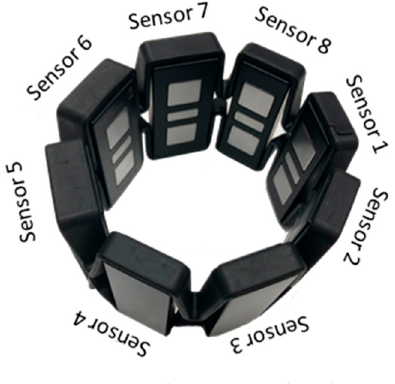
Figure 2. The Myo armband.